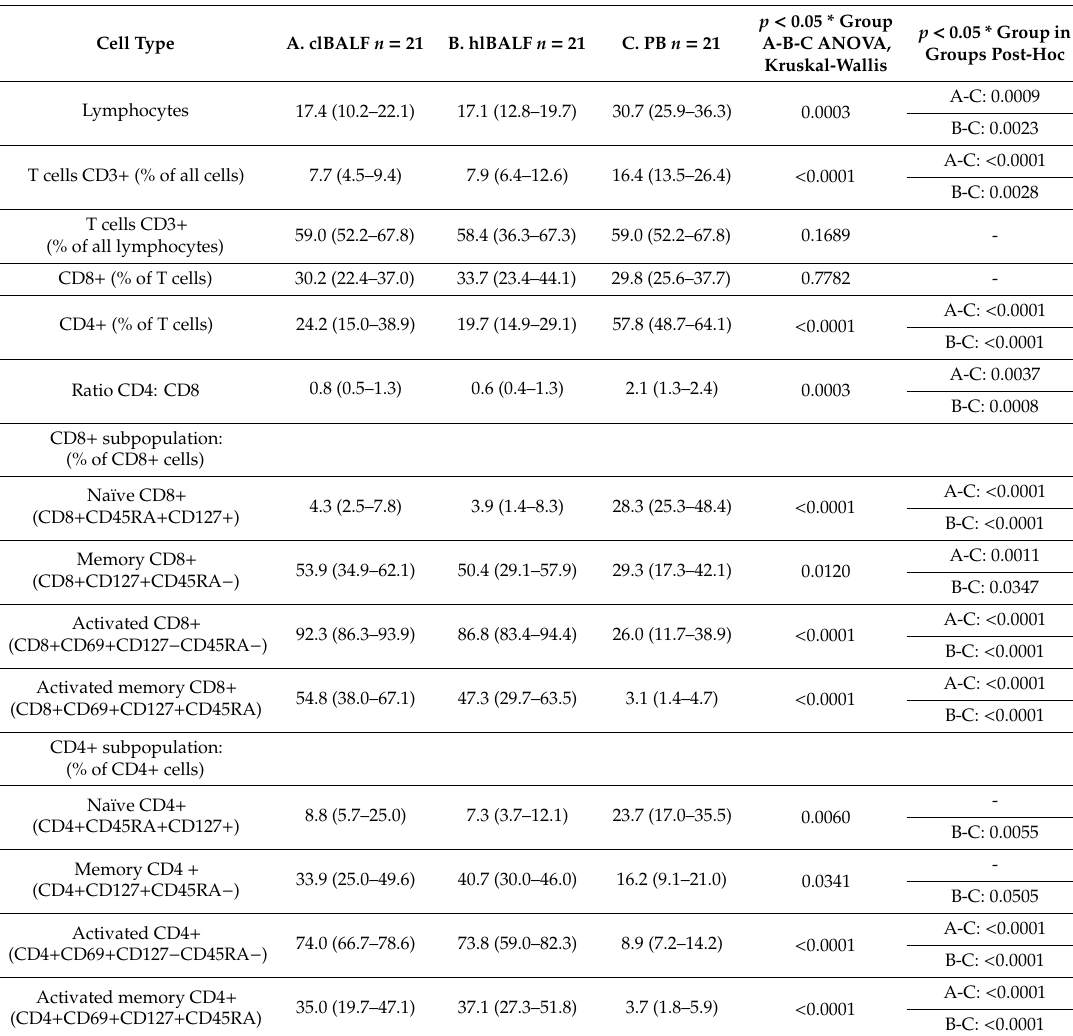
Table 2. Lymphocyte subtypes in patients with lung cancer. Comparison of the proportion of cells between three compartments: the tumor environment clBALF, ‘healthy’ lung (hlBALF) and peripheral blood (PB). Data expressed as median (p25–p75). * p <